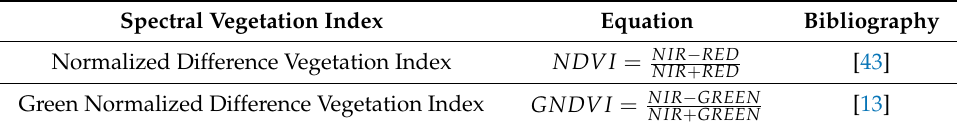
Table 1. The spectral vegetation indices that were used in this study.